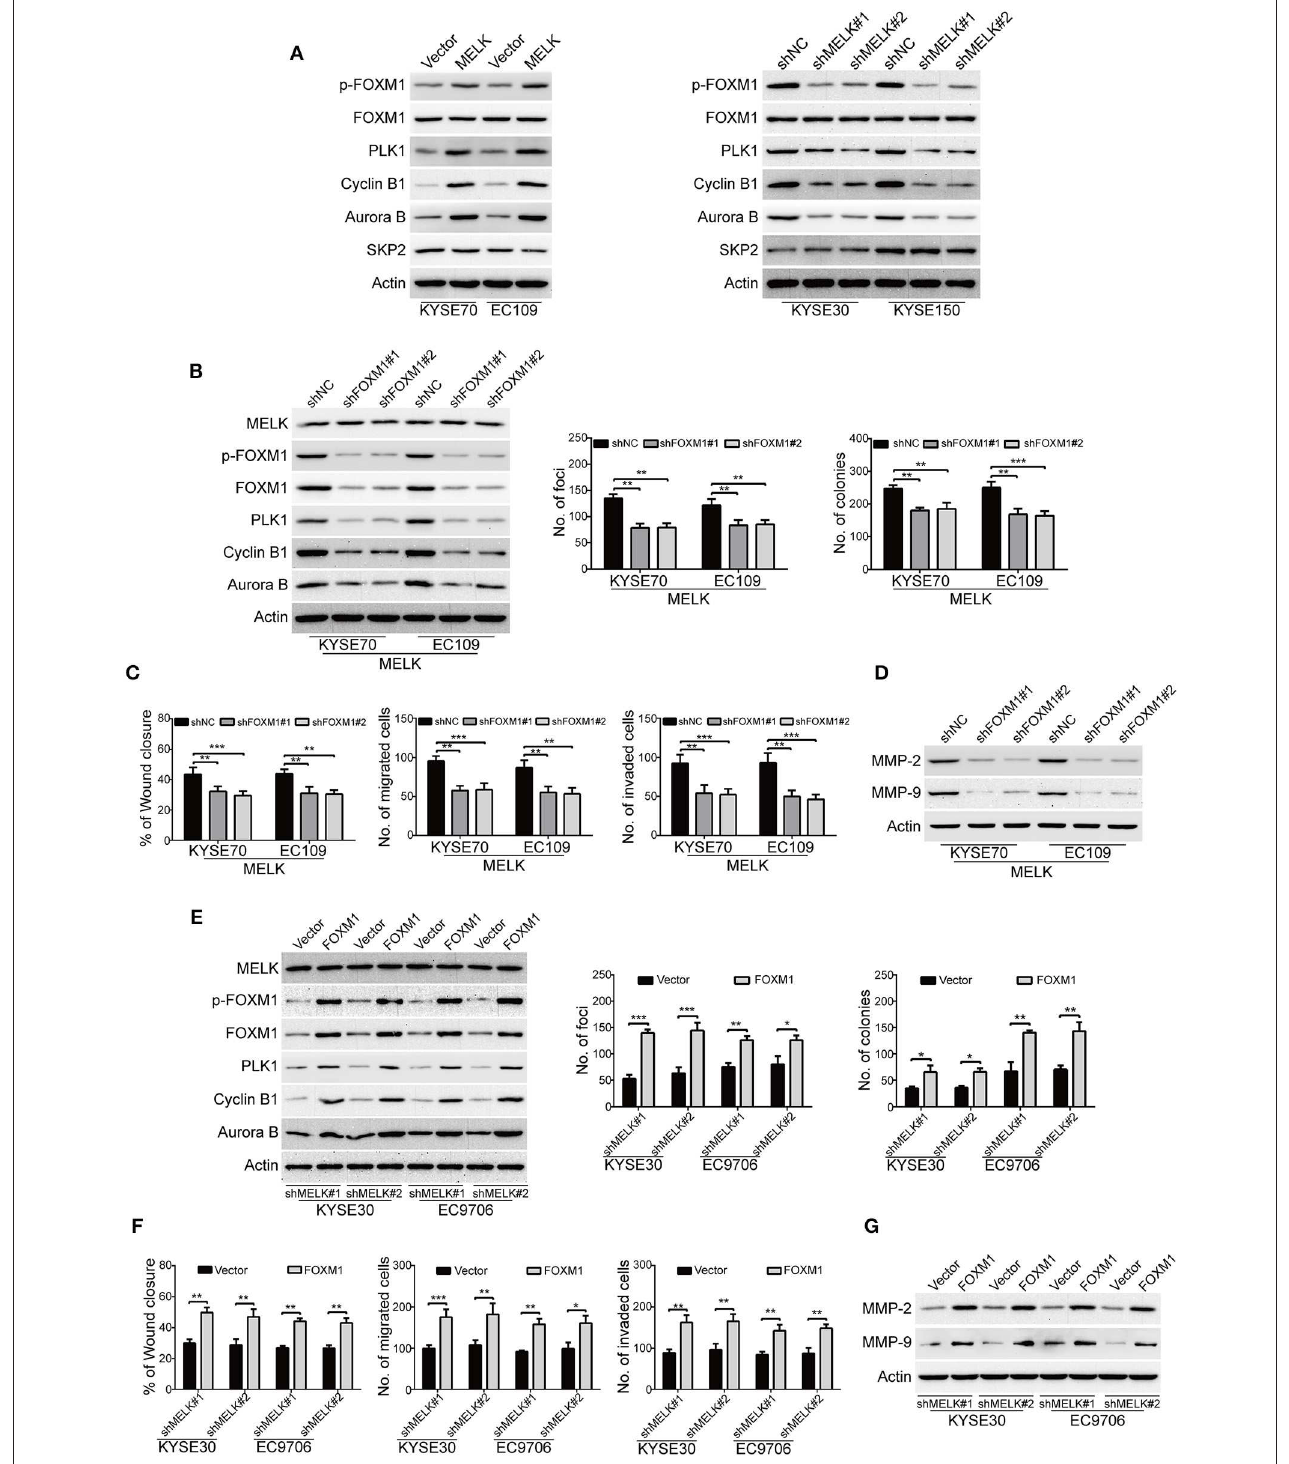
FIGURE 4 | MELK promotes the growth, migration and invasion through activation of FOXM1 signaling. (A) Immunoblotting analysis was used to determine the protein levels of p-FOXM1 (Thr600), FOXM1, PLK1, Cyclin B1, Aurora B and SKP2 in ESCC cells with MELK-overexpression (KYSE70 and EC109) or knockdown (KYSE30 and EC9706). Actin served as an internal control. (B) Western blotting analysis was carried out to measure the efficiency of FOXM1 shRNAs (shFOXM1#1 and shFOXM1#2) in MELK-depleted ESCC cells (left). Knockdown of FOXM1 drastically inhibited the frequency of focus formation (middle) and colony formation in